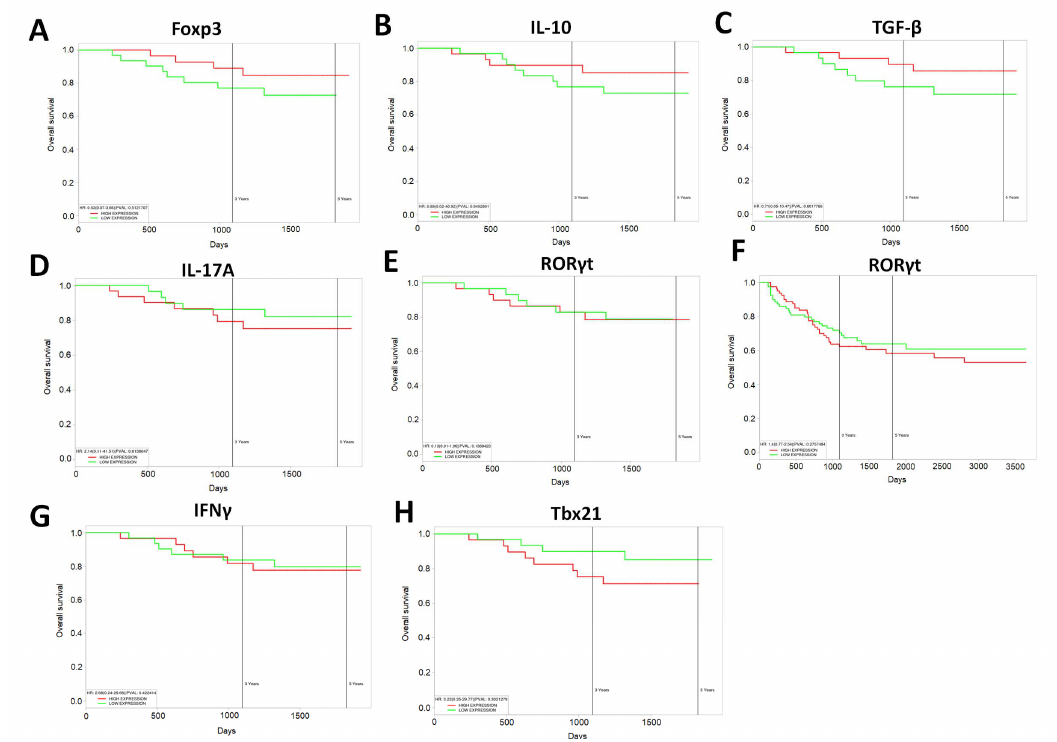
Figure 7. TCGA datasets for colorectal cancer from The Cancer genome Atlas (TCGA, https: // cancergenome.nih.gov / ) were used to correlate gene expression with patient survival over a 5-year periodormore. Correlationstopatientsurvivalwereperformedbasedonthefollowinggeneexpressions: ( A ) FoxP3, ( B ) IL-10, ( C ) TGF- β , ( D ) IL-17A, ( E ) ROR- γ t, ( F ) ROR- γ t (past five year interval), ( G ) IFN- γ